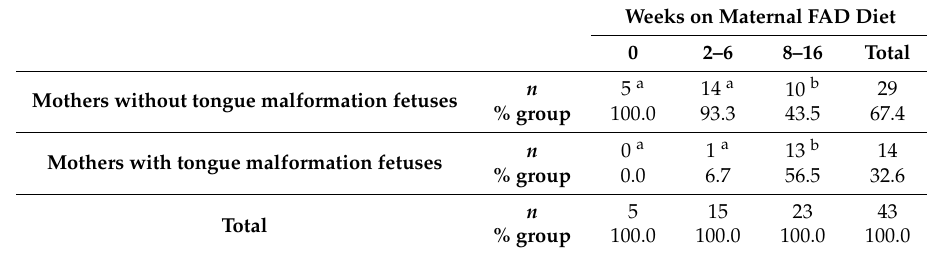
Figure 2. Morphological study of the tongue and head. ( a ) Control fetus: (a1) Frontal view of the head showing a triangular mouth (M: mandible); (a2) Inferior view showing the mandible (M) and a wide arcade (dotted line); (a3) The section shows the body of the tongue (asterisk) and the lingual-mandible sulcus (black arrows), with the mandibular bone (MB) observed laterally; ( b ) Fetus with microglossia and micrognathia: (b1) Frontal view of the head showing the triangular mouth smaller than the one from the control, due to a reduction of the mandible (M); (b2) The inferior view shows a smaller mandible (M), with a narrow arcade (dotted line); (b3) The section shows that the tongue is smaller, the muscles are disorganized (asterisk) and the lingual septum is absent; the lingual-mandible sulcus is enlarged (black arrows) and the mandibular bone (MB) is smaller; ( c ) Fetus with aglossia and agnathia: (c1) In a frontal view, the mouth is observed as an anterior to posterior cleft, due to the absence of the mandible (black arrow); (c2) The inferior view of the mouth is cleft-shaped (black arrow); (c3) In the section of the head, the tongue appears as a small bulge (asterisk), with absent or indistinguishable muscles (UM). If agnathia was concomitant, the mandible was also absent. Scale bar: 1 mm (a1, a2, b1, b2, c1 and c2); scale bar: 100 µ m (a3, b3 and c3). Table 2. General outcome. Number mothers with tongue malformation fetuses with respect to weeks on a maternal folic acid-deficient (FAD) diet.